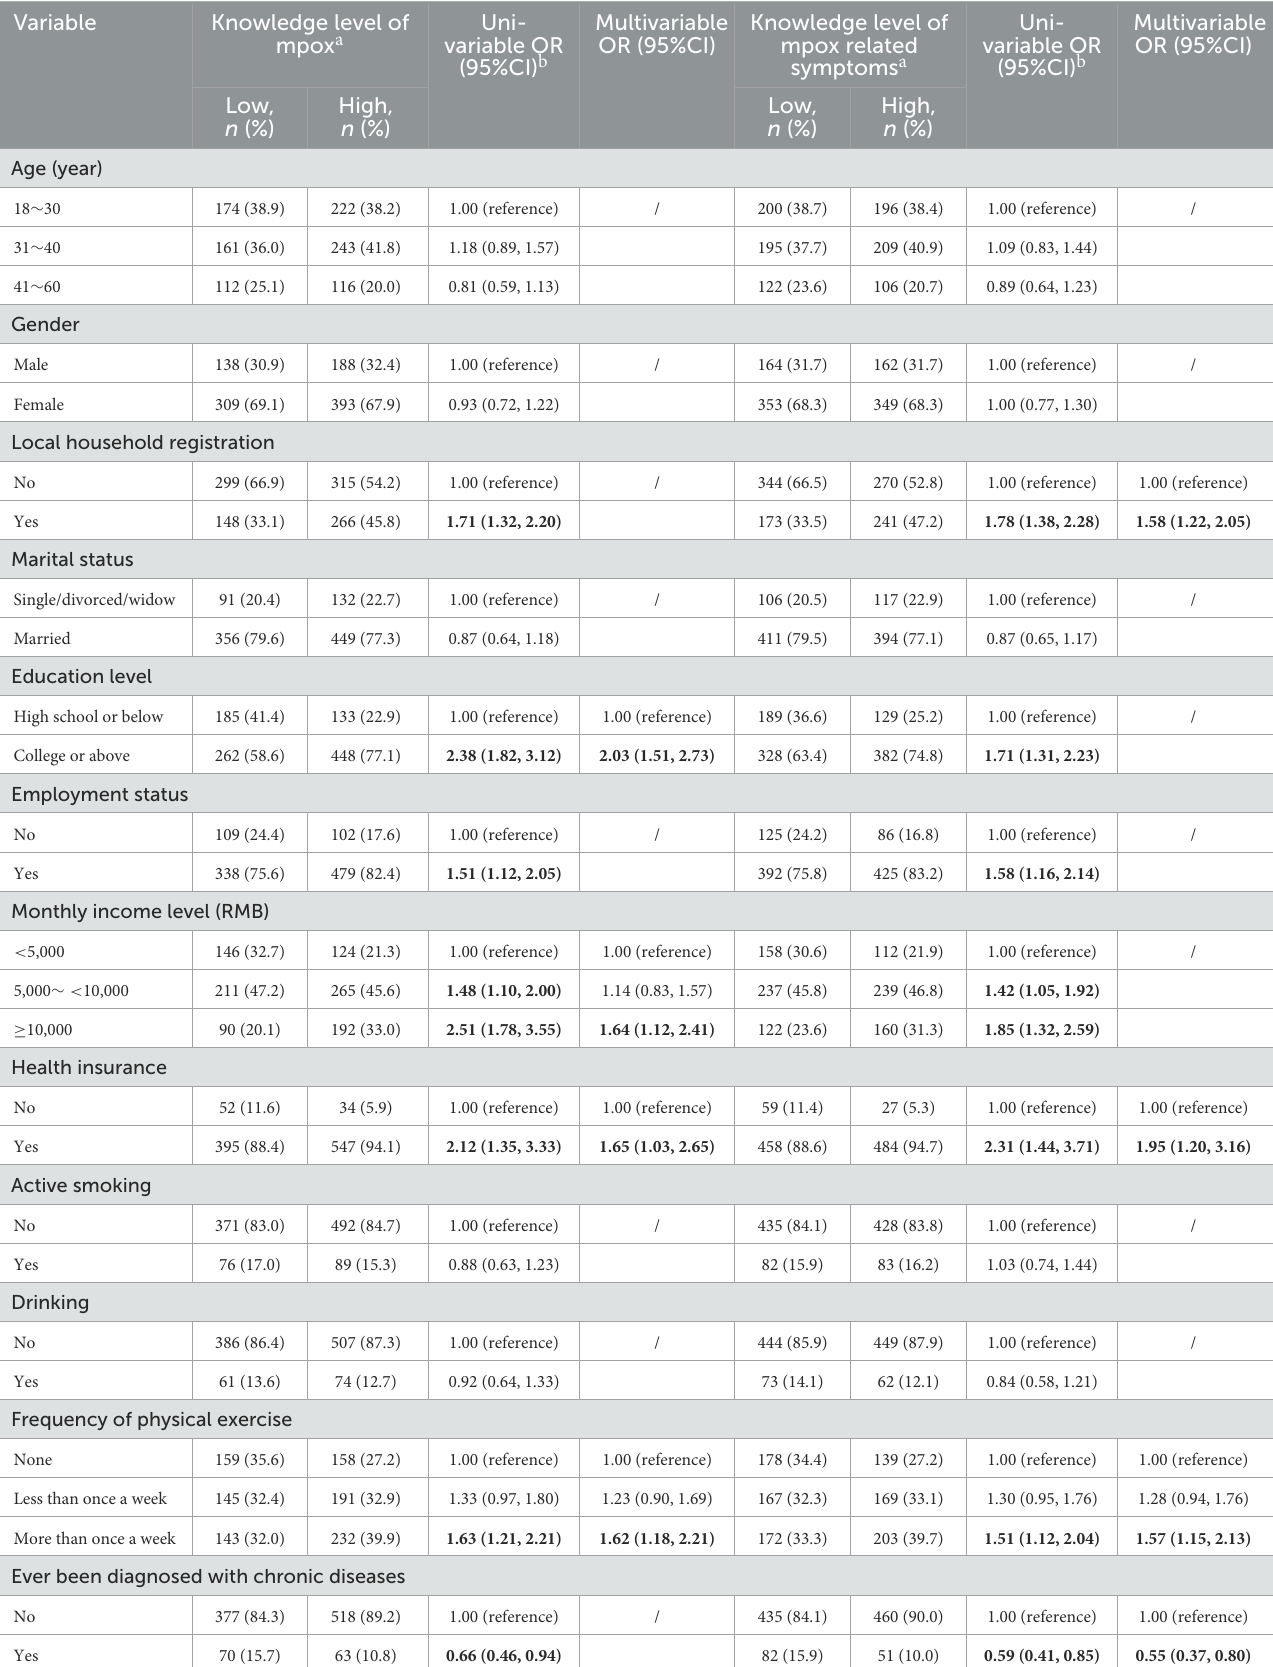
TABLE 3 Factors associated with specific knowledge of mpox and related symptoms in community residents ( N =